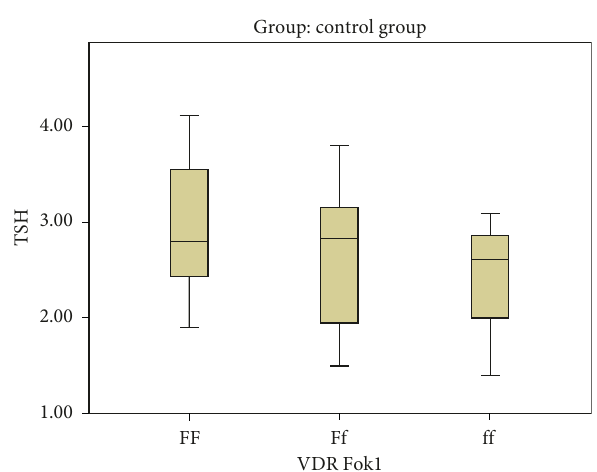
Figure 2: Variation of different Fok1 alleles with TSH levels in the control group.